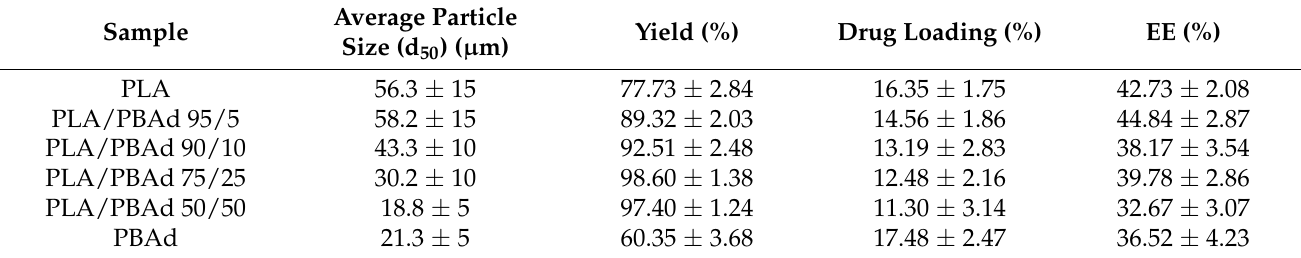
Figure 5. SEM images for the ARI-loaded MPs prepared using PLA, PBAd and the newly synthesized PLA/PBAd block copolymers as the matrix/carriers. Table 3. Yield, drug loading and EE of the prepared ARI